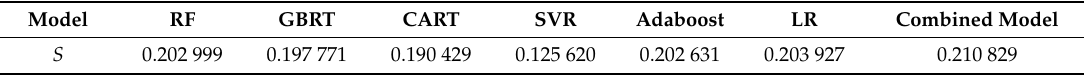
Table 5. Similarity index of each